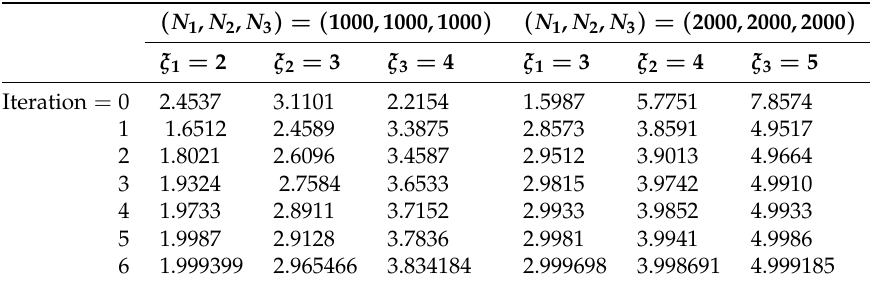
Table 1. Estimates of ξ = ( ξ 1 , ξ 2 , ξ 3 ) for N = 3000 and N = 6000 data simulated from Exponential distribution with mean